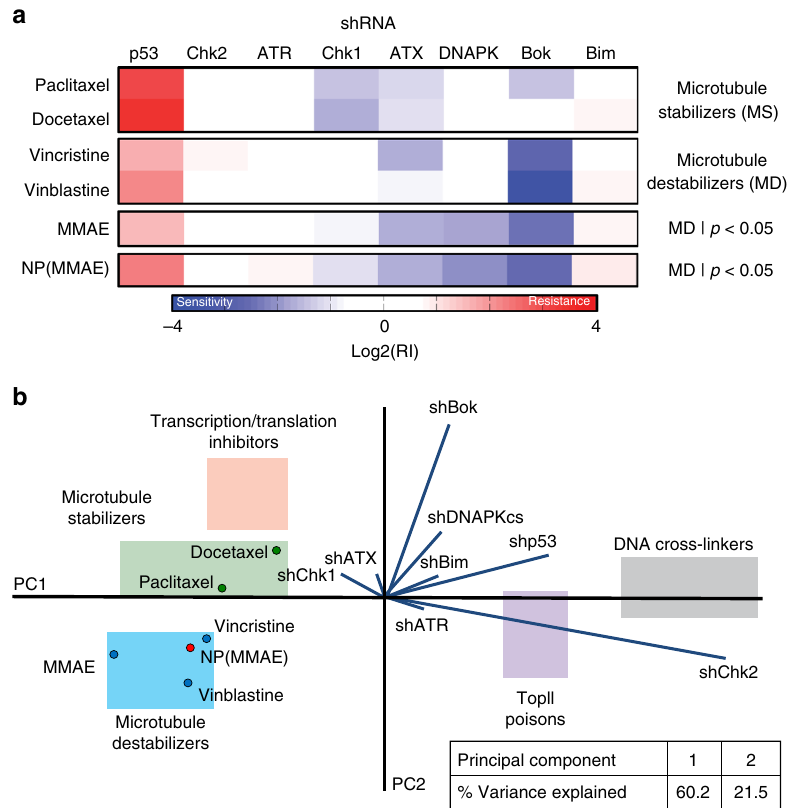
Fig. 3 Therapeutic classi fi cation of MMAE-conjugated nanoparticles using an shRNA screen. a Heat maps and RNAi signature classi fi cations of conventional microtubule stabilizers (paclitaxel, docetaxel) and microtubule destabilizers (vincristine, vinblastine), the highly potent toxin MMAE, and its nanoparticle conjugate (NP(MMAE)). b Principal component analysis of RNAi signatures from each of these aforementioned agents as well as in relation to known transcription/translation inhibitors, topoisomerase II (topII) poisons, and the DNA cross-linkers reference